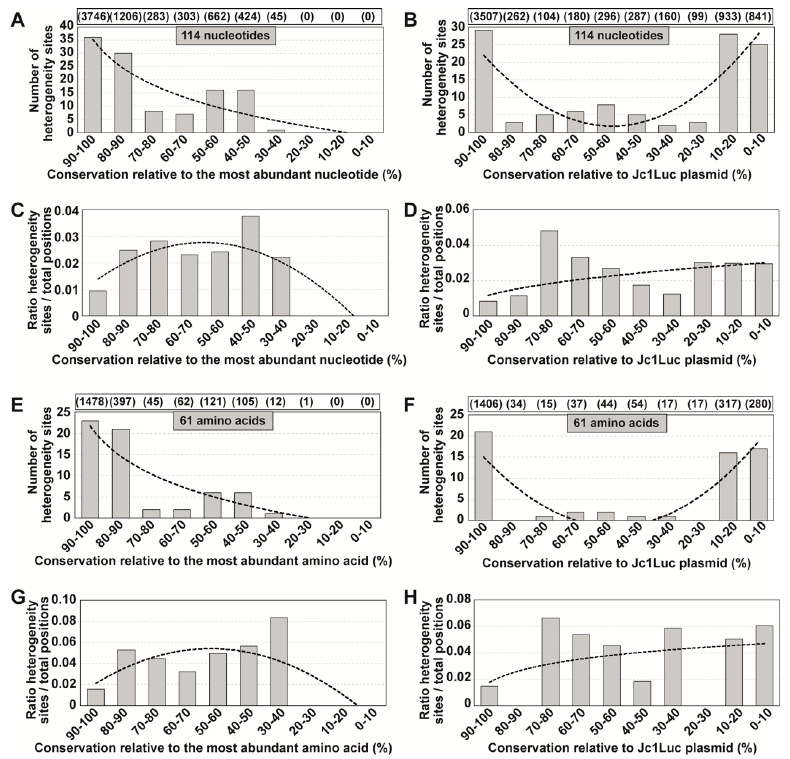
Figure 5. Distribution of sites of heterogeneity in HCV quasispecies among residue conservation groups defined according to LANL. Sites of heterogeneity are those identified within HCV genomic residues 2769 and 9377 (H77 numbering). In this case, the analysis was performed separately with 983 sequences of genotype G1 and 129 sequences of genotype G2 (excluding one G2c and one G2k sequence due to the presence of an insertion (https://hcv.lanl.gov/content/sequence/HCV/ToolsOutline.html)). ( A ) The genomic position at which each heterogeneity site is found is assigned to the conservation range calculated relative to the most abundant nucleotide in each position according to the LANL alignment. Conservation groups are indicated in abscissa, and the number of heterogeneity sites in each group is given in ordinate. The total number of nucleotides that fall in each conservation category is indicated in parenthesis in the upper box. The discontinuous line corresponds to function y = − 15.83ln(x) + 35.306 (R 2 = 0.7957). ( B ) Same as A except that the conservation groups in LANL alignment were calculated using the HCV sequence in plasmid Jc1Luc as reference. The discontinuous line corresponds to function y = 1.1439x 2 − 11.892x + 32.767 (R 2 = 0.6507). ( C ) Data of A normalized to the number of residues in each conservation group. The discontinuous line corresponds to function y = -0.0012x 2 + 0.0103x + 0.0047 (R 2 = 0.7036). ( D ) Data of B normalized to the number of residues in each conservation group. The discontinuous line corresponds to function y = 0.0117x0.4096 (R 2 = 0.2824). ( E – H ) Same as A-D but at the amino acid level. In this case, the possible conservation windows covered 0% to 100%. The defining functions are E: y = − 10.39ln(x) + 21.797 (R 2 = 0.7694); F: y = 0.9015x 2 − 9.5106x + 23.7 (R 2 = 0.7085); G: y = − 0.0023x 2 + 0.0222x + 0.0011 (R 2 = 0.5193); H: y = 0.0127ln(x) + 0.0178 (R 2 = 0.1291). The position of each heterogeneity site is given in Table S3.